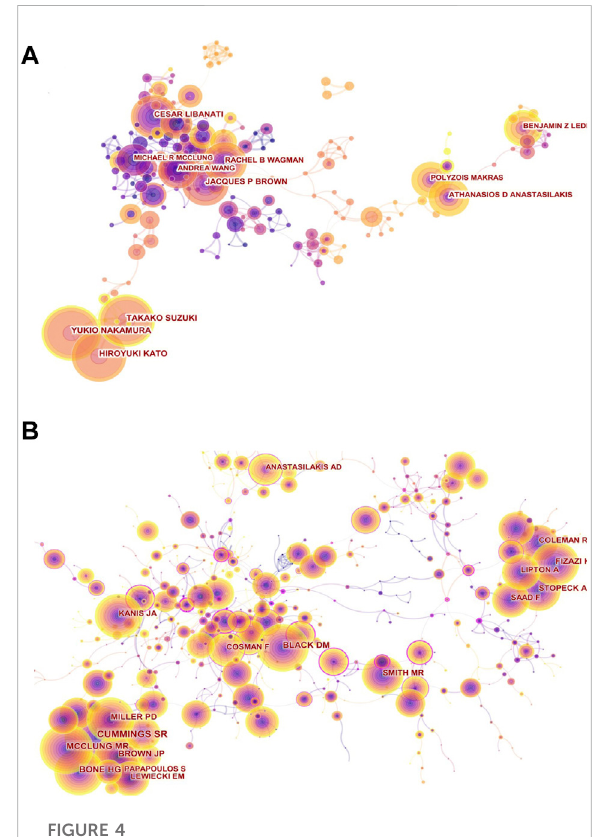
FIGURE 4 Visual network diagram of authors and cited authors. (A) Authors ’ collaboration network map in denosumab from 2011 to 2021. The nodes represent authors. The lines represent cooperation. The different colors represent different years. (B) Co-citation network of cited authors in the denosumab fi eld from 2011 to 2021. The nodes represent co-cited authors, and the lines represent co-citation relationships. Different colors in the nodes represent different years. The circle area represents the publication volume, and the purple outer circle represents higher